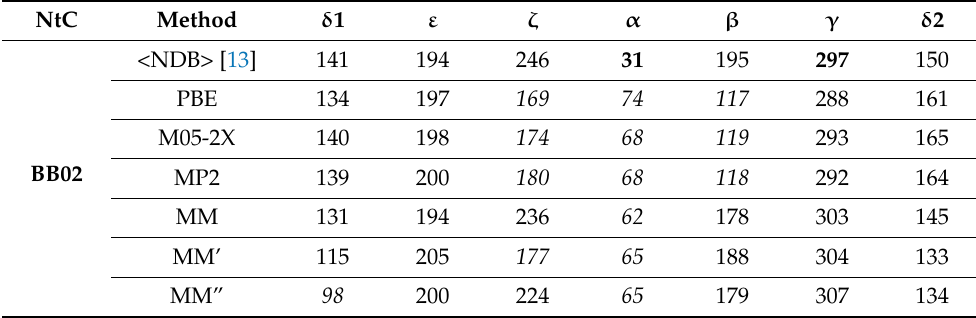
Table 4. Torsion angles of the sugar-phosphate backbone of conformational classes deviating from the energy minima of a separate SPB